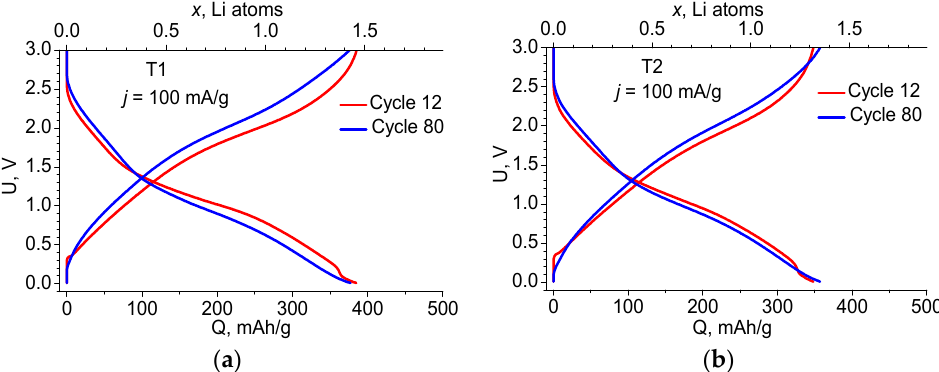
Figure 3. Charge–discharge curves of the 12th and 80th cycles at j = 100 mA/g for the T1 ( a ) and T2 ( b ) anodes.